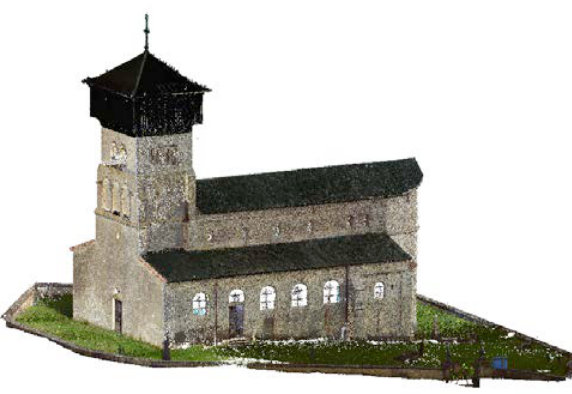
Figure 5. Colorized point cloud of the church (24 million